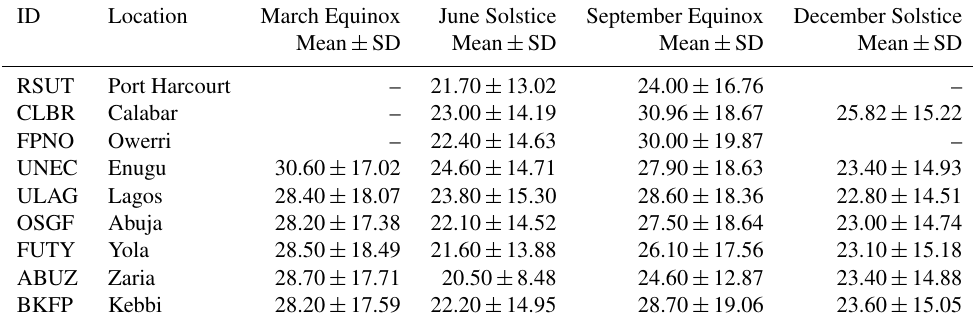
Table 2. Seasonal mean values of